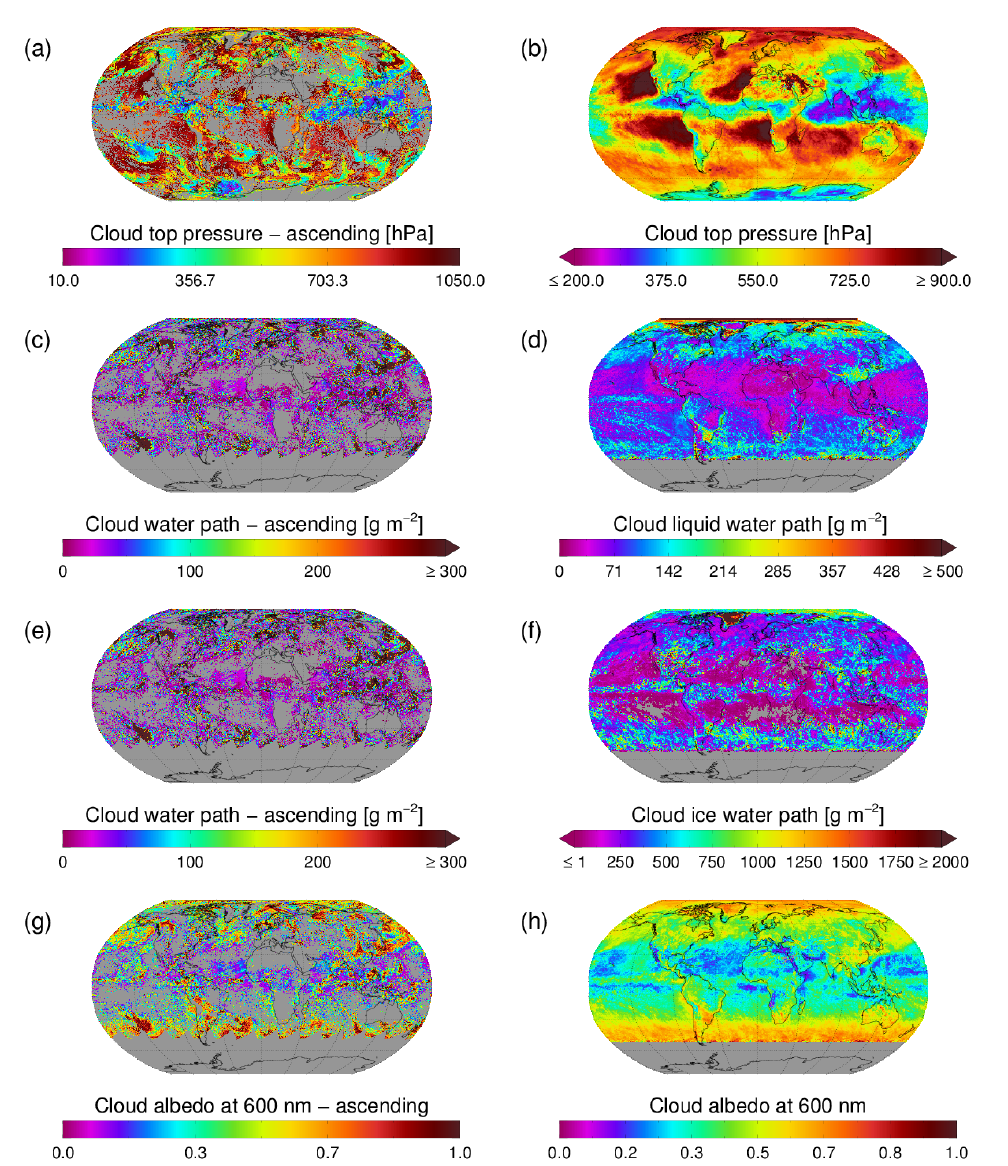
Figure 6. As Fig. 5 but for cloud-top pressure (a–b) , liquid water path (c–d) , ice water path (e–f) , and spectral cloud albedo at 0.6µm (g–h) for Level-3U (a, c, e, g) and Level-3C (b, d, f, h) products. Panels (c) and (e) both show the Level-3U cloud water path, which represents liquid water path in liquid cloud pixels and ice water path in ice cloud